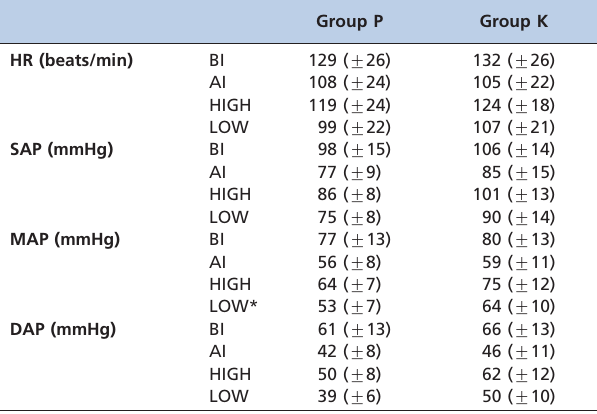
Table 1 - Patient and anesthesia characteristics.